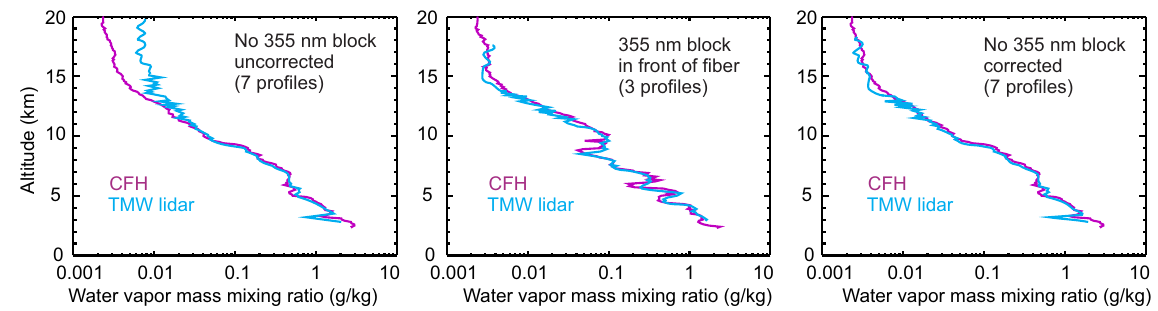
Fig. 8. Comparison of mean water vapor mixing ratio profiles measured simultaneously by the TMW lidar and CFH during MOHAVE-I. Left plot: lidar signals contaminated by fluorescence (no 355 nm block). Center plot: lidar signals free of fluorescence (355nm block installed). Right plot: same as left plot, but after fluorescence correction is applied to lidar signals.